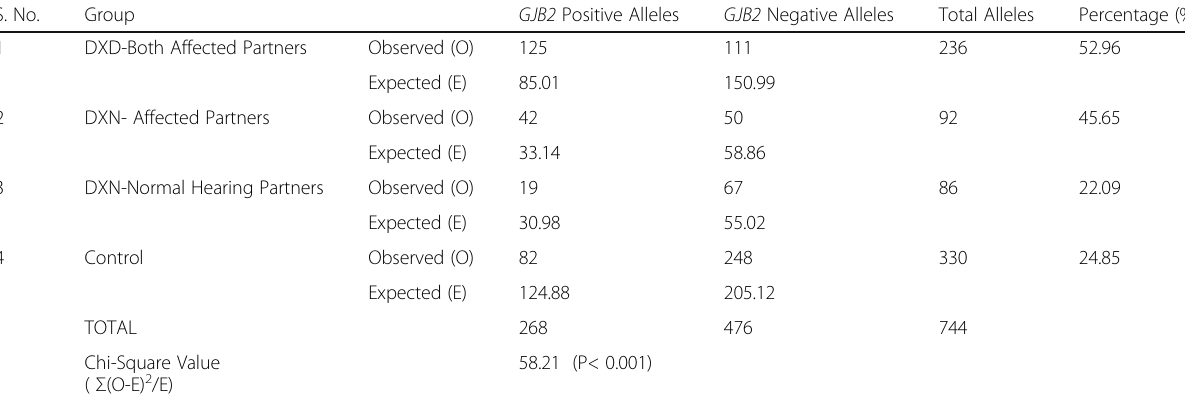
Table 16 Chi-square analysis of GJB2 variants among the four groups in our study S.